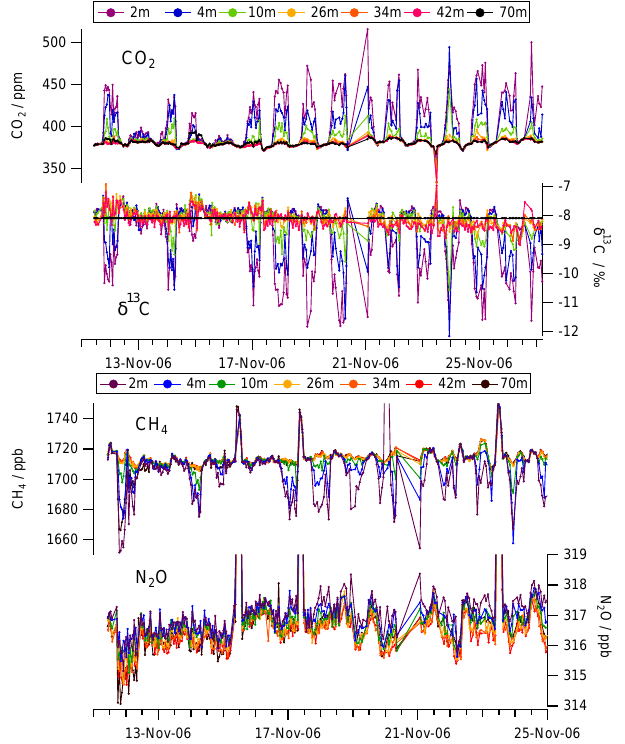
Fig. 11. Time series of (a) CO 2 and δ 13 C in CO 2 and (b) CH 4 and N 2 O during a 3-week campaign at the Ozflux tower site near Tumbarumba, SE Australia, in November 2006. Seven-point ver- tical profiles of each species from 2–70m were measured every 30min; colours represent measurements at heights above the sur- face shown in the legend. The top of the forest canopy is approx. 40m above the surface.